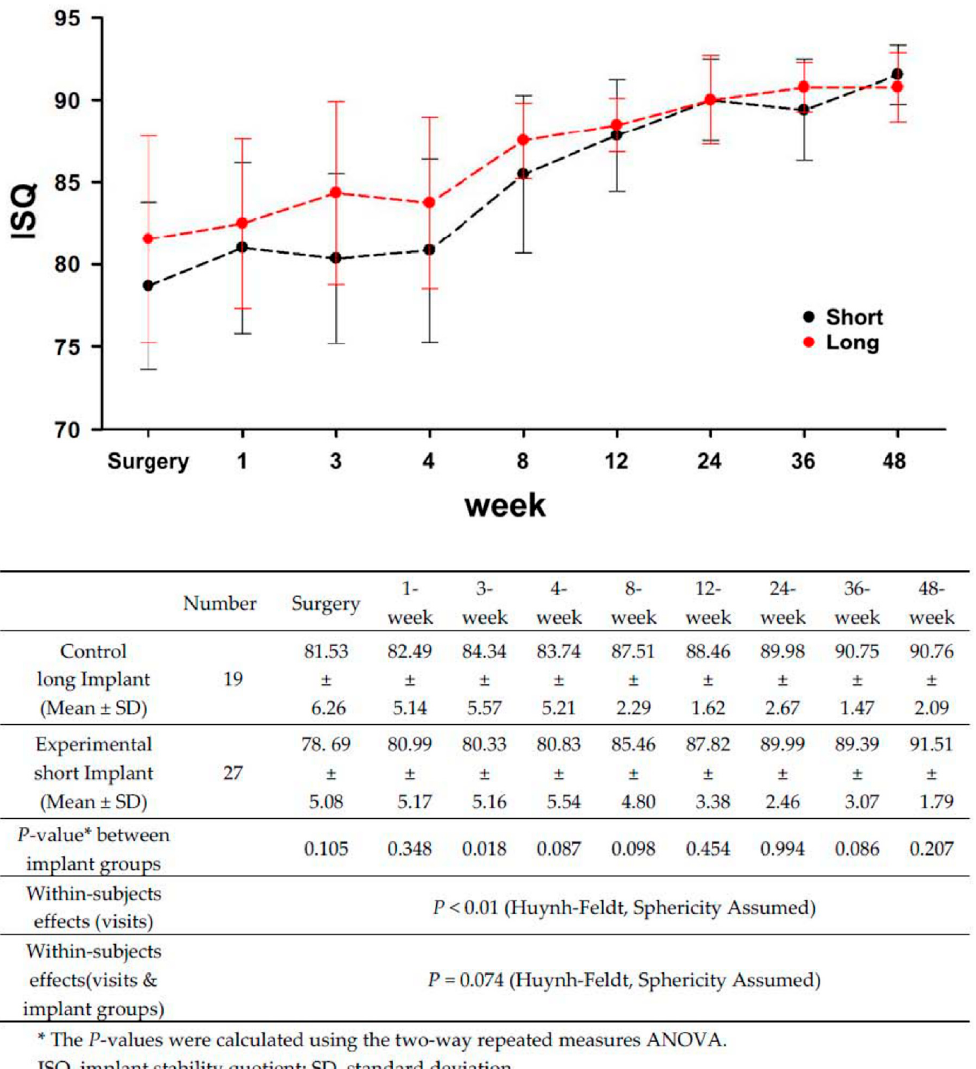
Figure 6. Comparison of stability in terms of the pattern of change in implant stability quotient (ISQ) during the 48-week observation period after implant